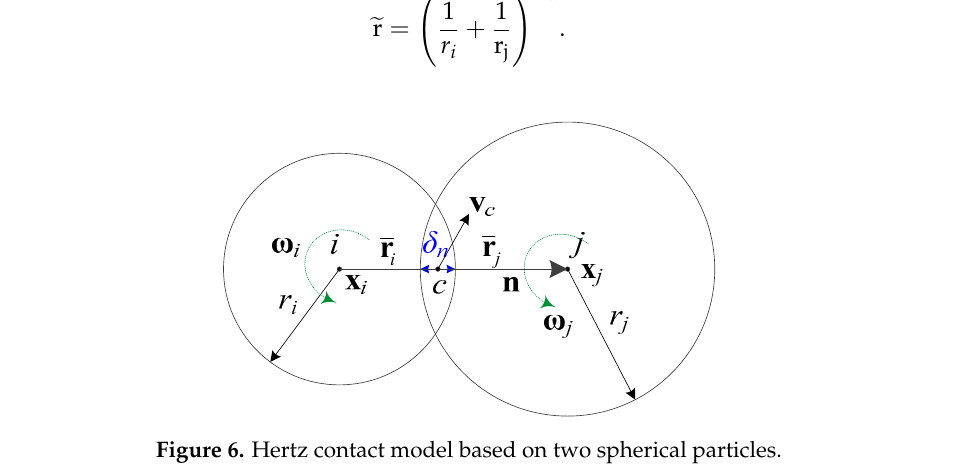
Figure 6. Hertz contact model based on two spherical particles.